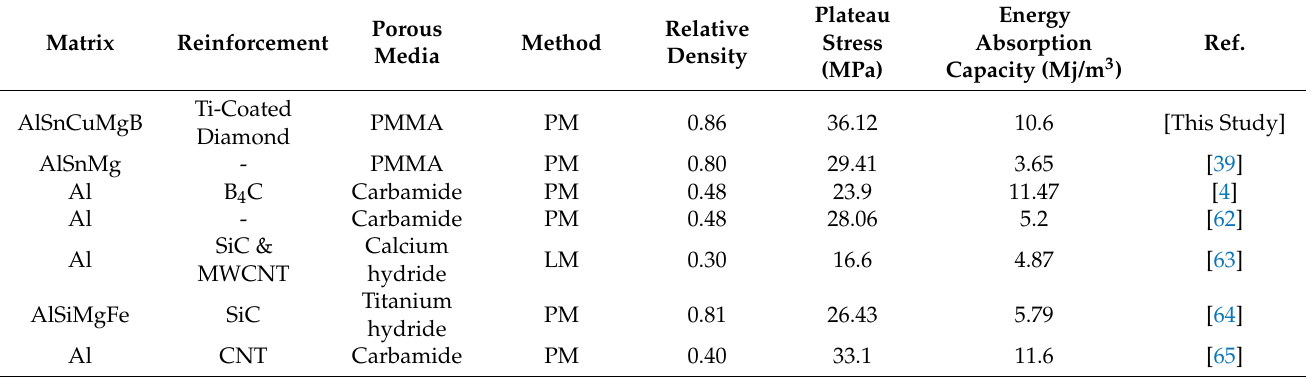
Table 12. Comparison of compressive properties obtained in this study with another